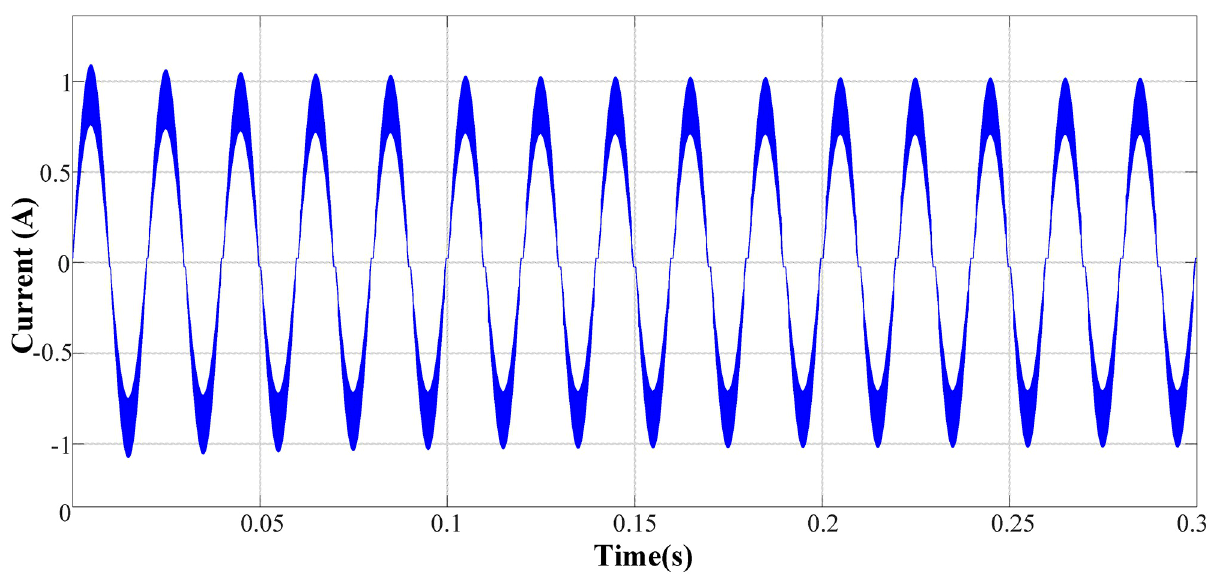
Fig 9. Input current waveform in normal operation mode.